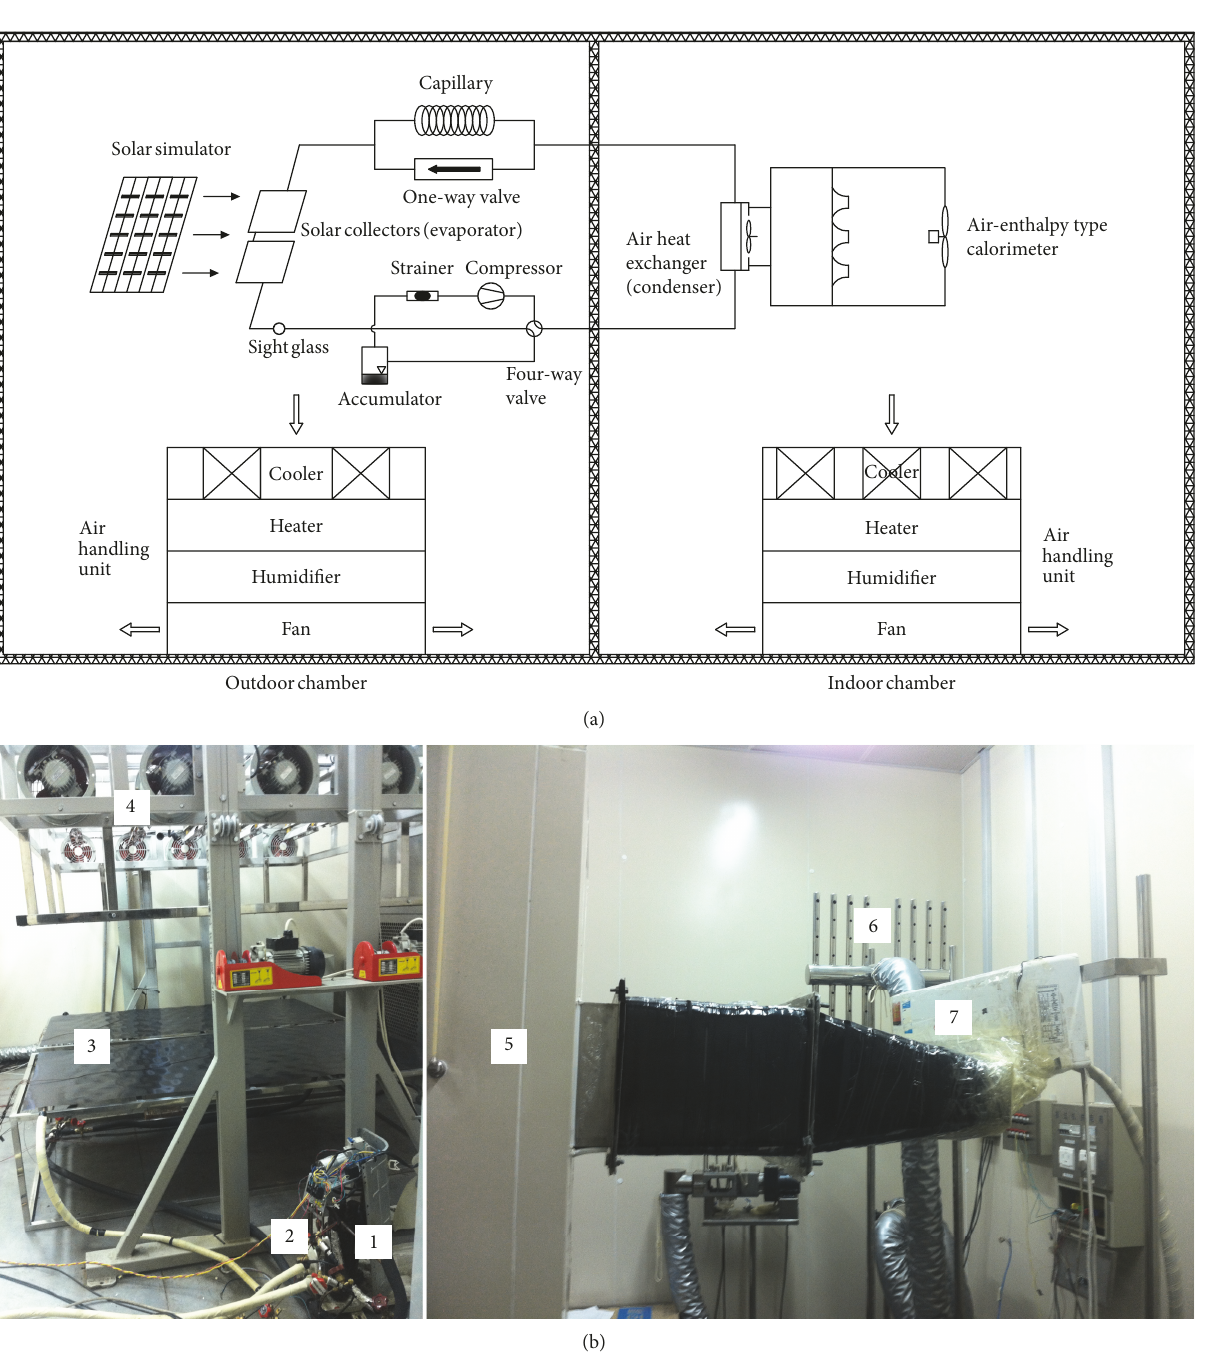
Figure 1: (a) A schematic diagram of the enthalpy di ff erence lab and the tested system (b) photo of the DX-SAHP system. (1) Compressor; (2) capillary tube; (3) bare plate evaporators; (4) solar simulator; (5) air-enthalpy type calorimeter; (6) indoor sampling device; (7) indoor air heat